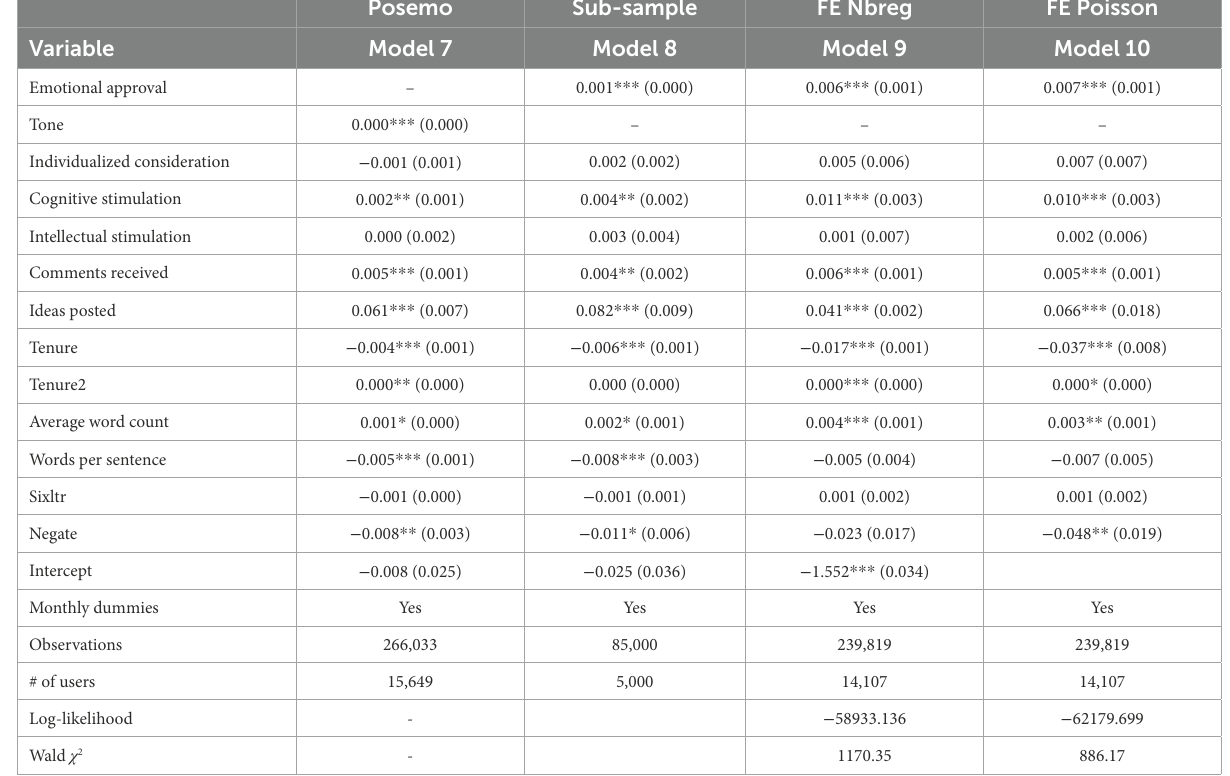
TABLE 6 Robustness check of the effects of verbal persuasion on